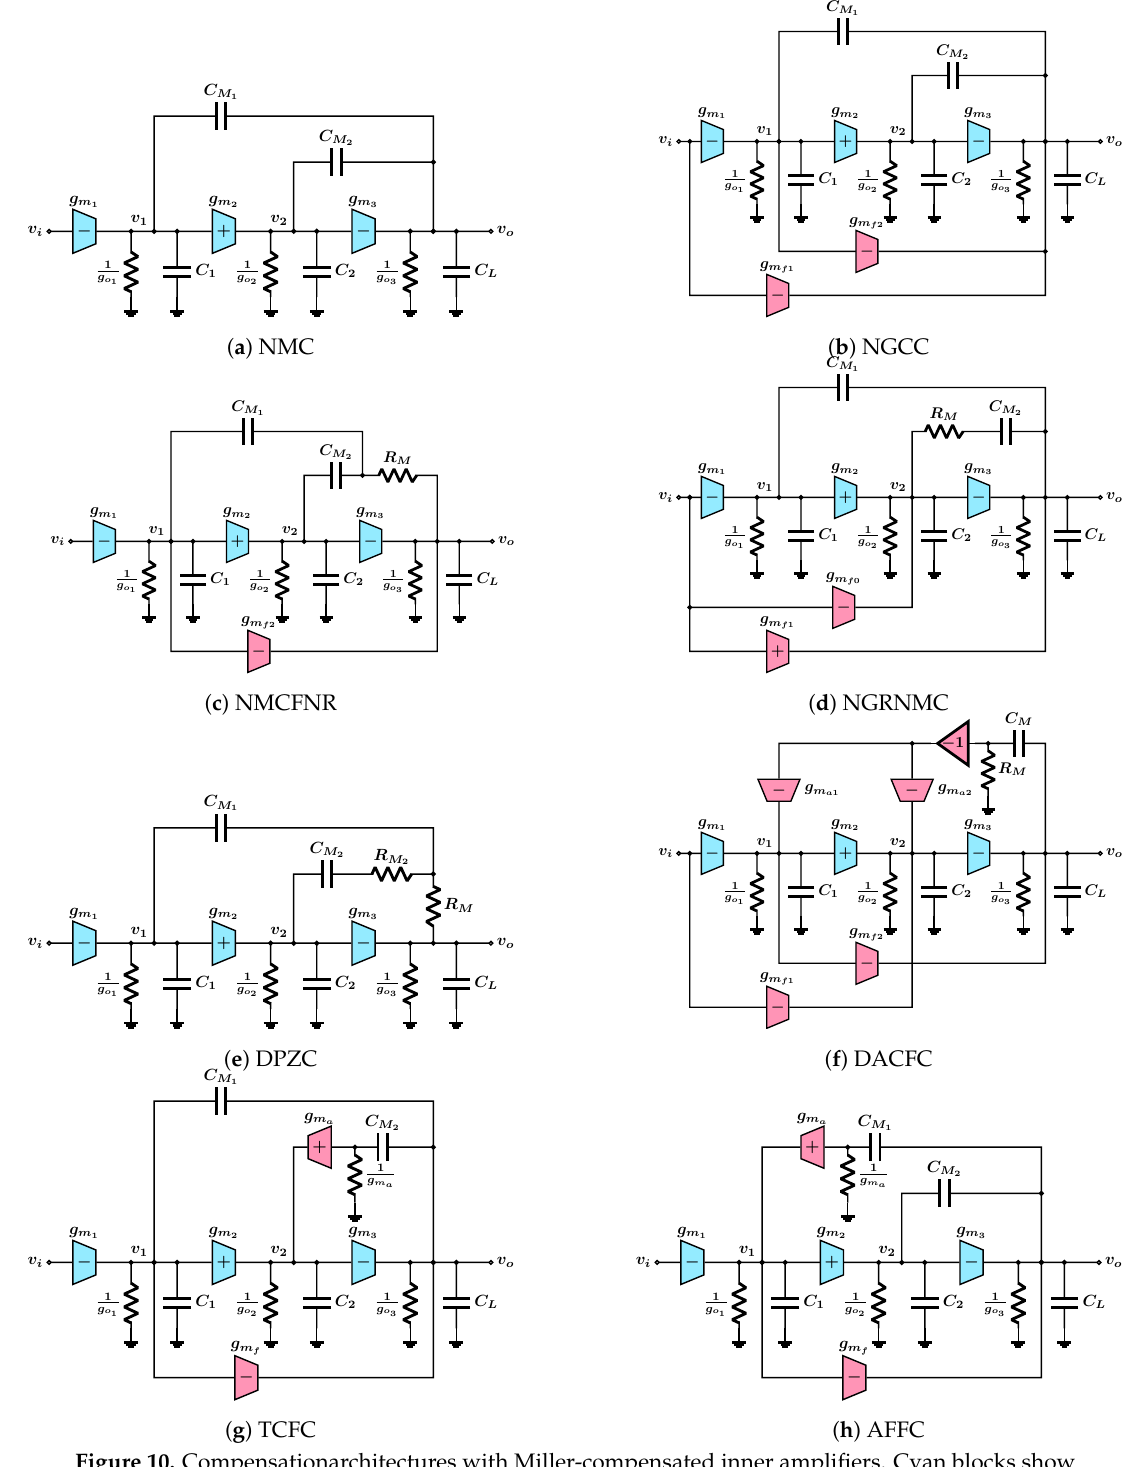
Figure 10. Compensationarchitectures with Miller-compensated inner amplifiers. Cyan blocks show the core amplifier stages while magenta blocks show additional transconductors used for compensation. The abbreviated architecture names are explained in Table